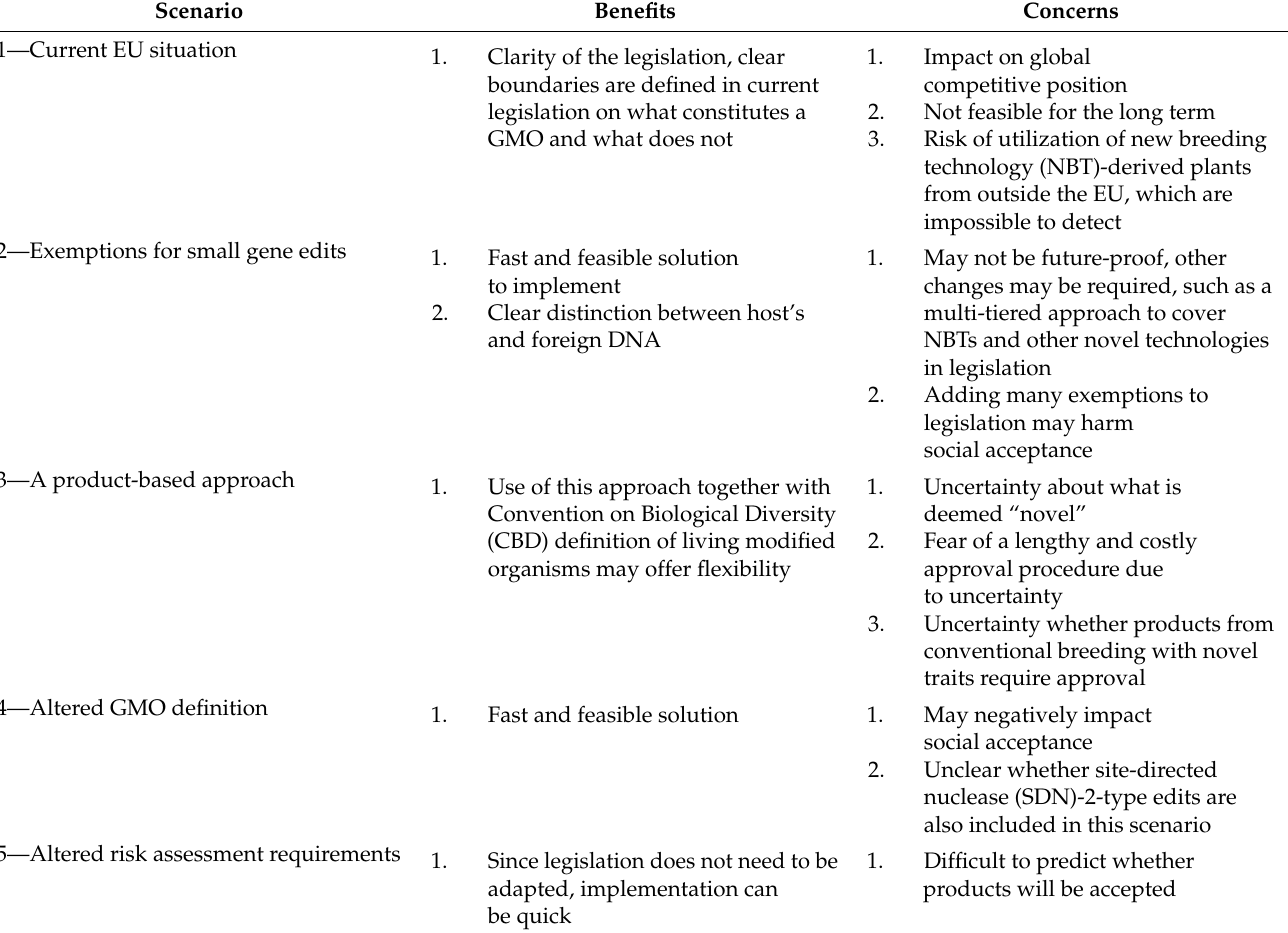
Table 2. Relevant stakeholders’ remarks to different regulatory